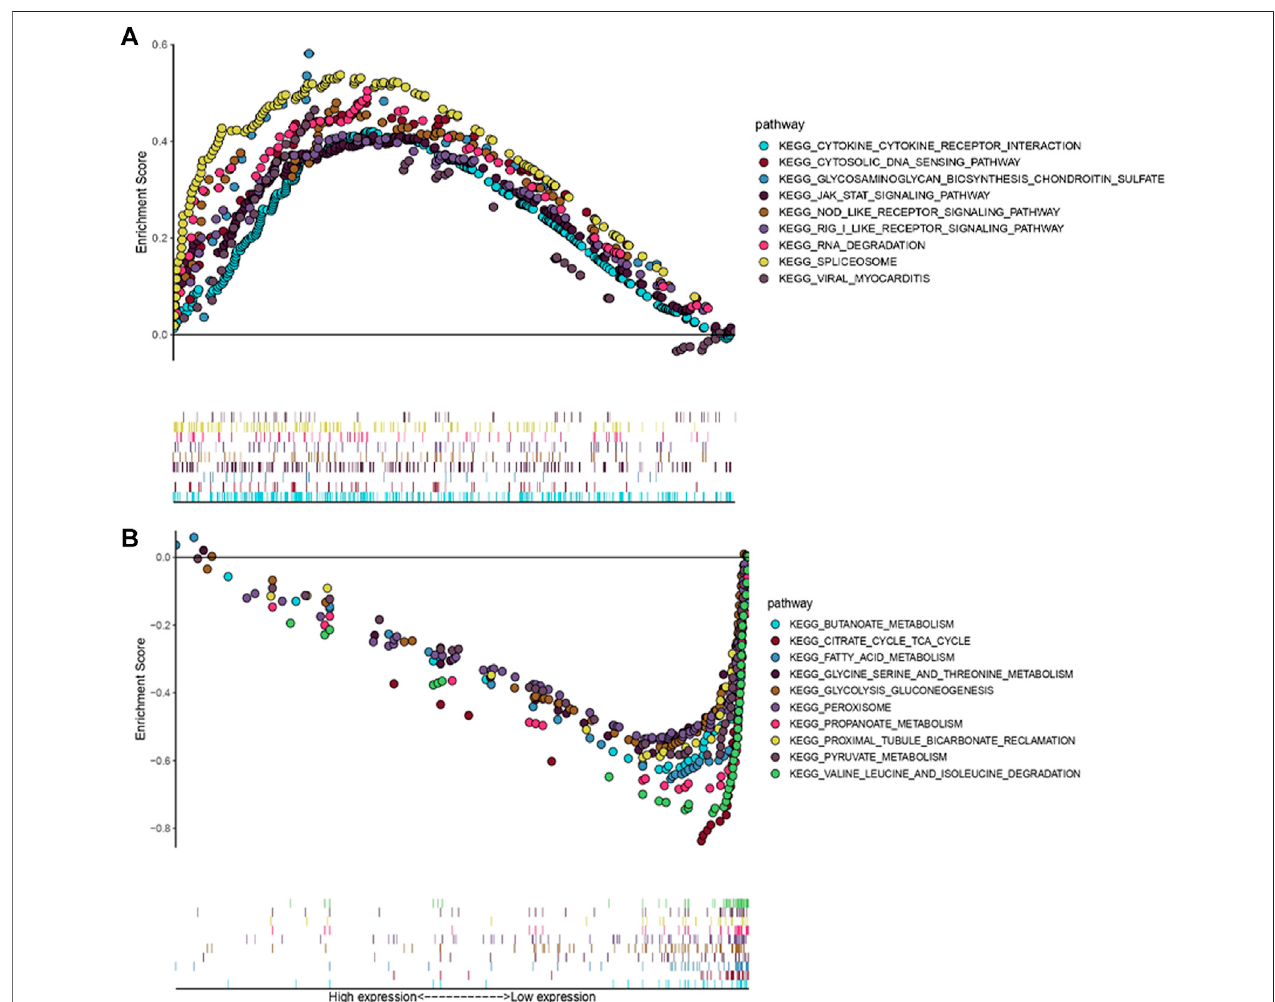
FIGURE 11 | GSEA associated with risk score [Gene matrix: c2.cp.kehh.v7.symbols.gmt (Curated), Number of permutations: 1,000, Permutation type: phenotype]. (A) KEGG pathways enriched in high risk group. (B) KEGG pathways enriched in low risk